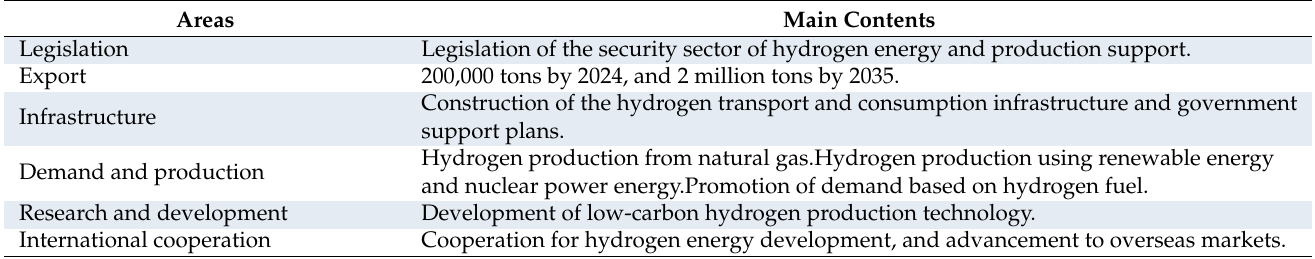
Table 3. Main contents of Russia’s Energy Development Strategy